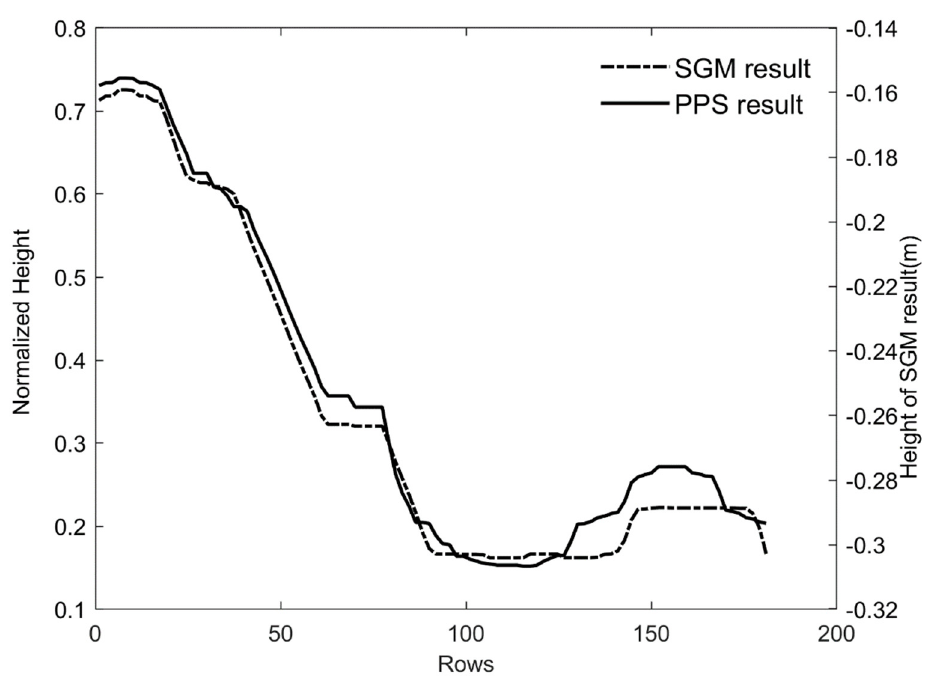
Figure 16. Height profile of ROI 1 in Yutu-2 rover imagery.